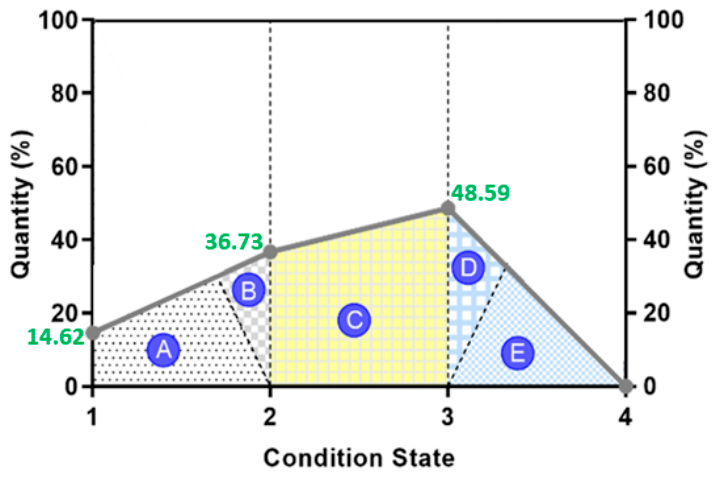
Figure 4. Multilinear function to aggregate element percentage quantities (age bin 1940). Table 3. Computation of element 12 health indexes, HI 12 (reinforced concrete deck).